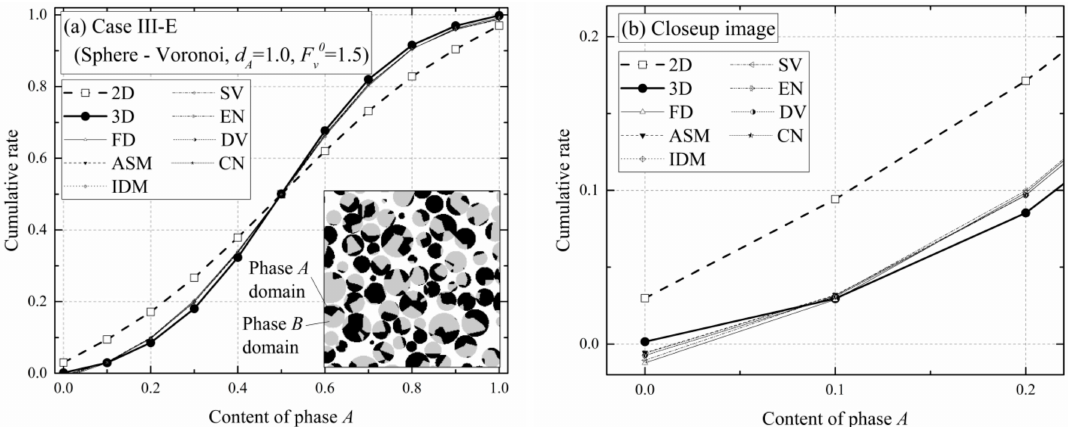
Figure 10. ( a ) Comparison of the 2D composition distribution, true 3D composition distribution, and seven types of 3D composition distributions estimated using seven types of texture analysis indices (FD, ASM, IDM, SV, EN, DV, and CN), for Case III-E (spherical particles with Voronoi internal structure, with d A = 1.0, F 0 v = 1.5), along with the corresponding partial sectional image; ( b ) Partial close-up of the chart in ( a ). FD—fractal dimension; ASM—angular second moment; IDM—inverse difference